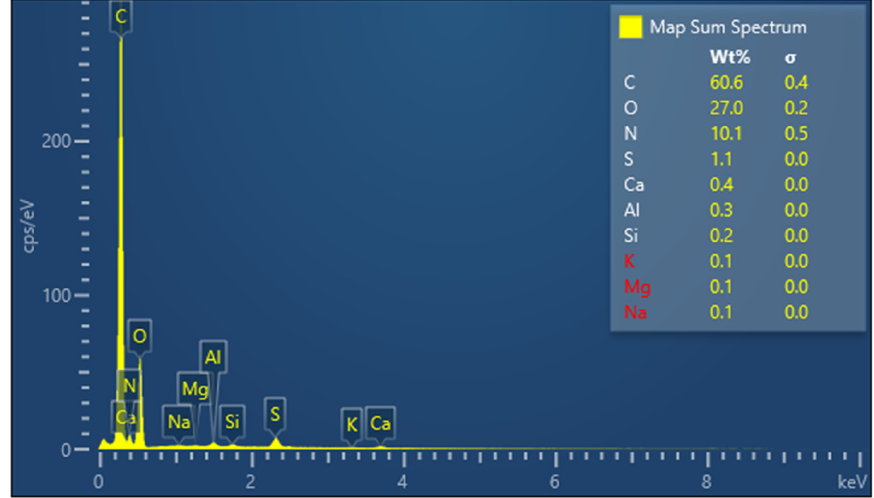
Figure 2. Percentage distribution of the component elements of the wool fibres.